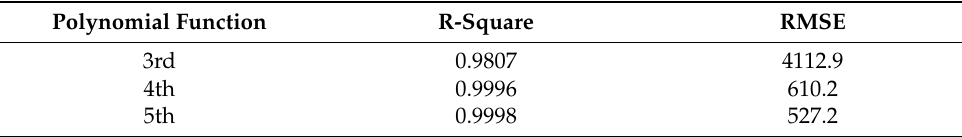
Table 4. Goodness evaluation of the curve fit.